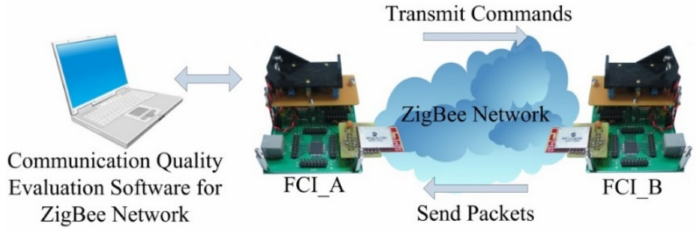
Figure 4. Architecture of the communication evaluation platform.